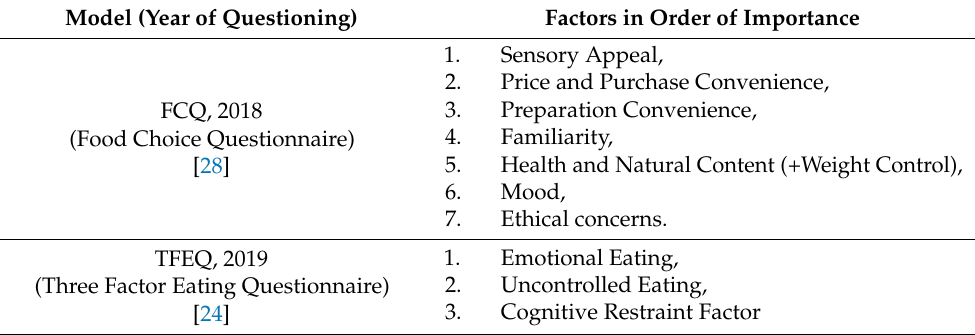
Table 7. Hungarian consumers’ food choice motivations based on different models in the pre- coronavirus period and during the first